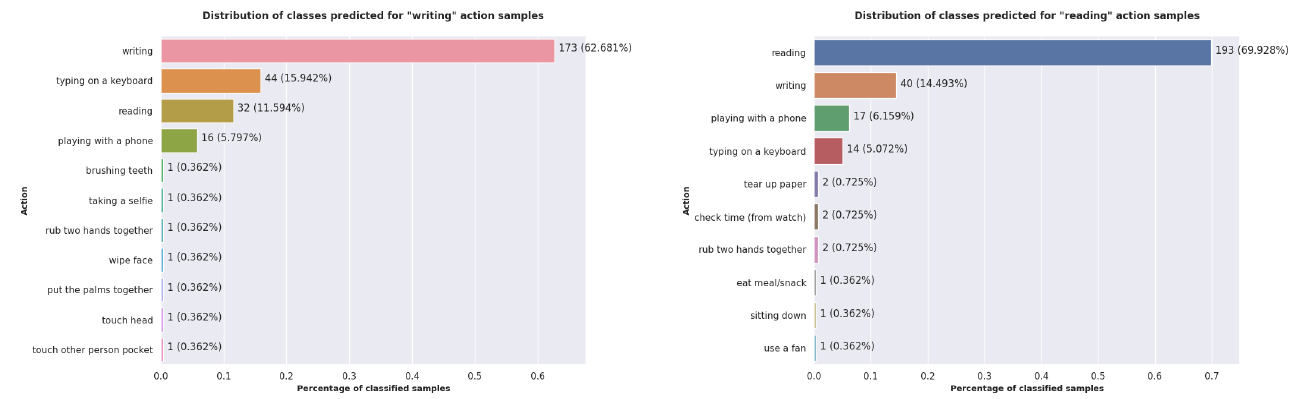
Figure 11. The distribution of the classes predicted by the proposed model for the writing and reading actions when using the Cross-Subject